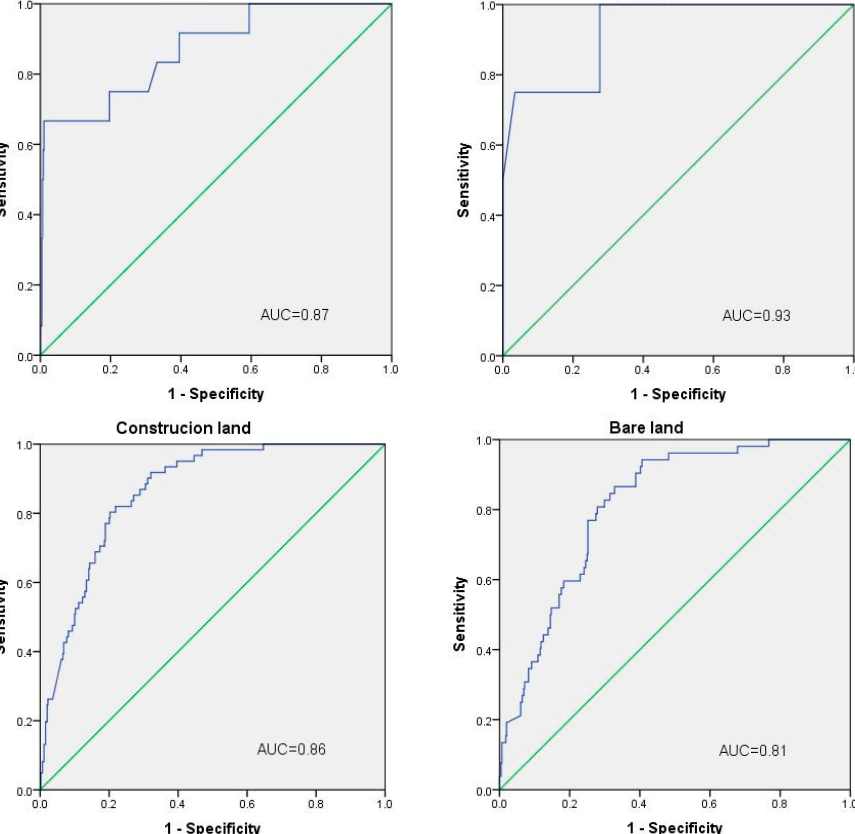
Figure A1. AUC values and ROC curves of each landscape type fitted by the artificial neural network (ANN).